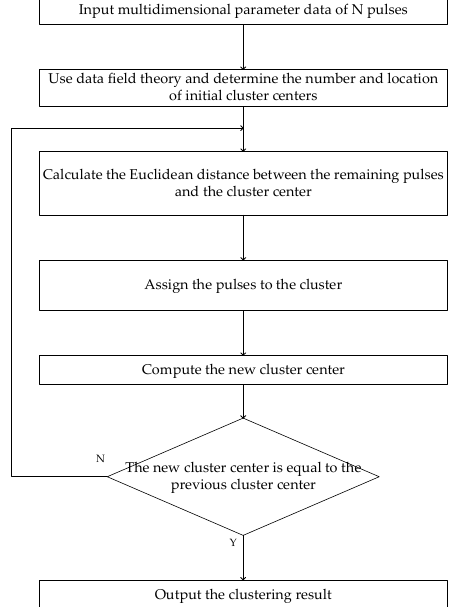
Figure 1. Flow chart of the K-means clustering algorithm based on data fields.